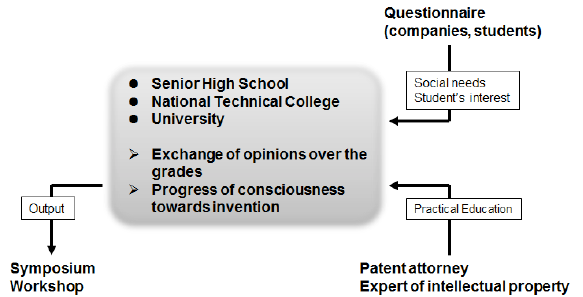
Figure 2. Framework of this educational research